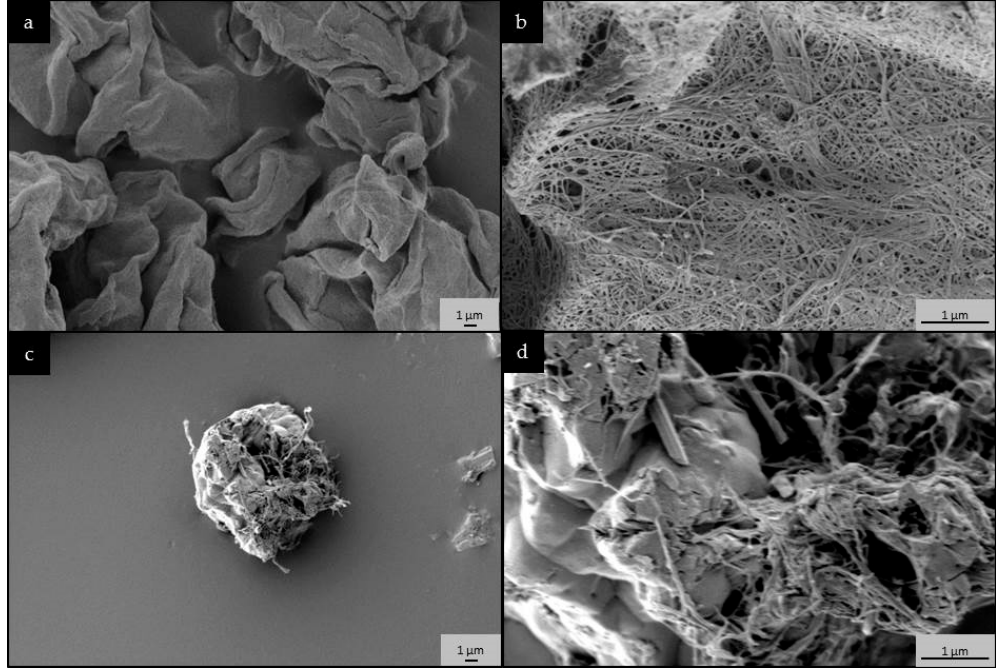
Figure 2. Scanning electron microscopy (SEM) images of: ( a , b ) Cladophora nanocellulose and ( c , d ) RSDAC materials. Observe the change in morphology from entangled fiber mesh in the unmodified Cladophora nanocellulose to highly porous beads in the RSDAC sample. Table 1. Physicochemical properties of Cladophora nanocellulose and RSDAC beads. Adapted from Rocha et al.